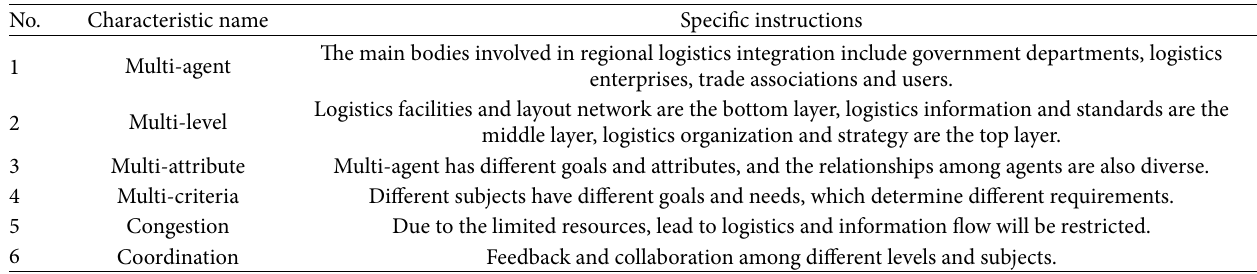
Figure 2: The three-dimensional hierarchical relationship of regional logistics integration network. Table 1: Supernetwork characteristics of regional logistics integration.